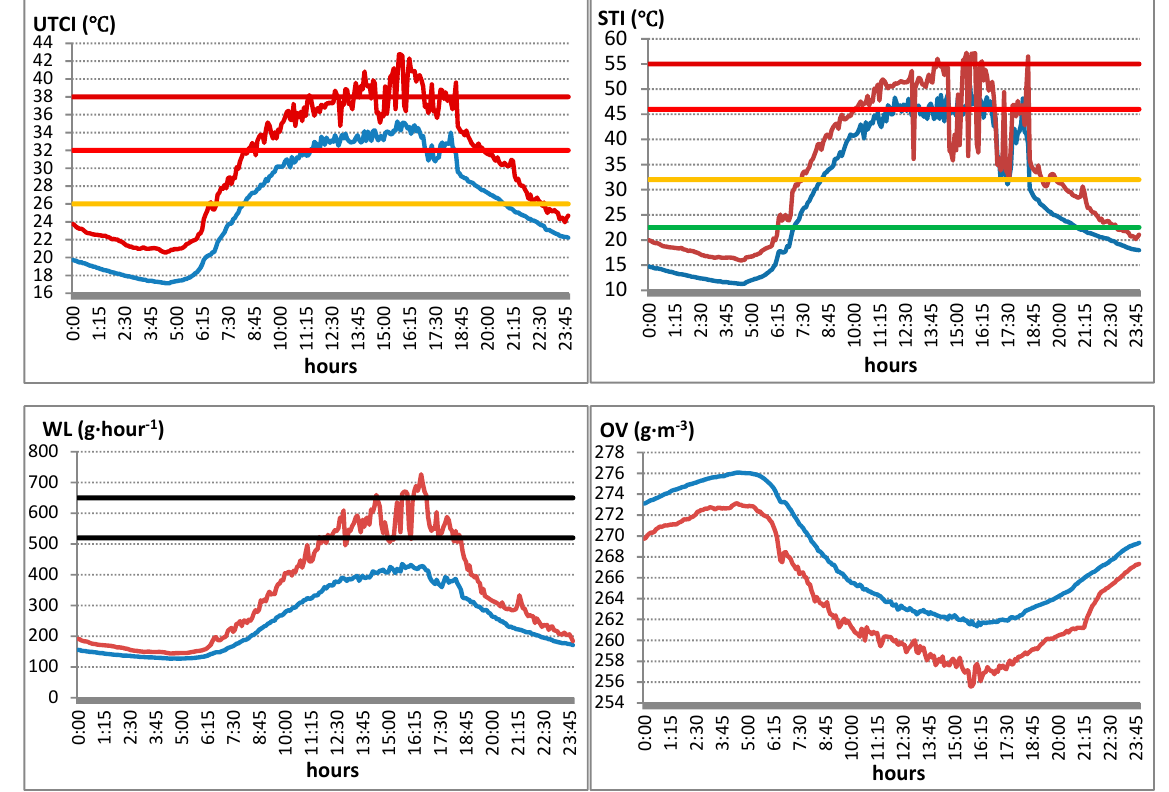
Figure 6. Average daily course of UTCI, STI, SW, and OV indices in Bydgoszcz on hot days in June 2019 (blue line) and on 26 June 2019 (red line) with marked ranges for UTCI, HSI, and SW.